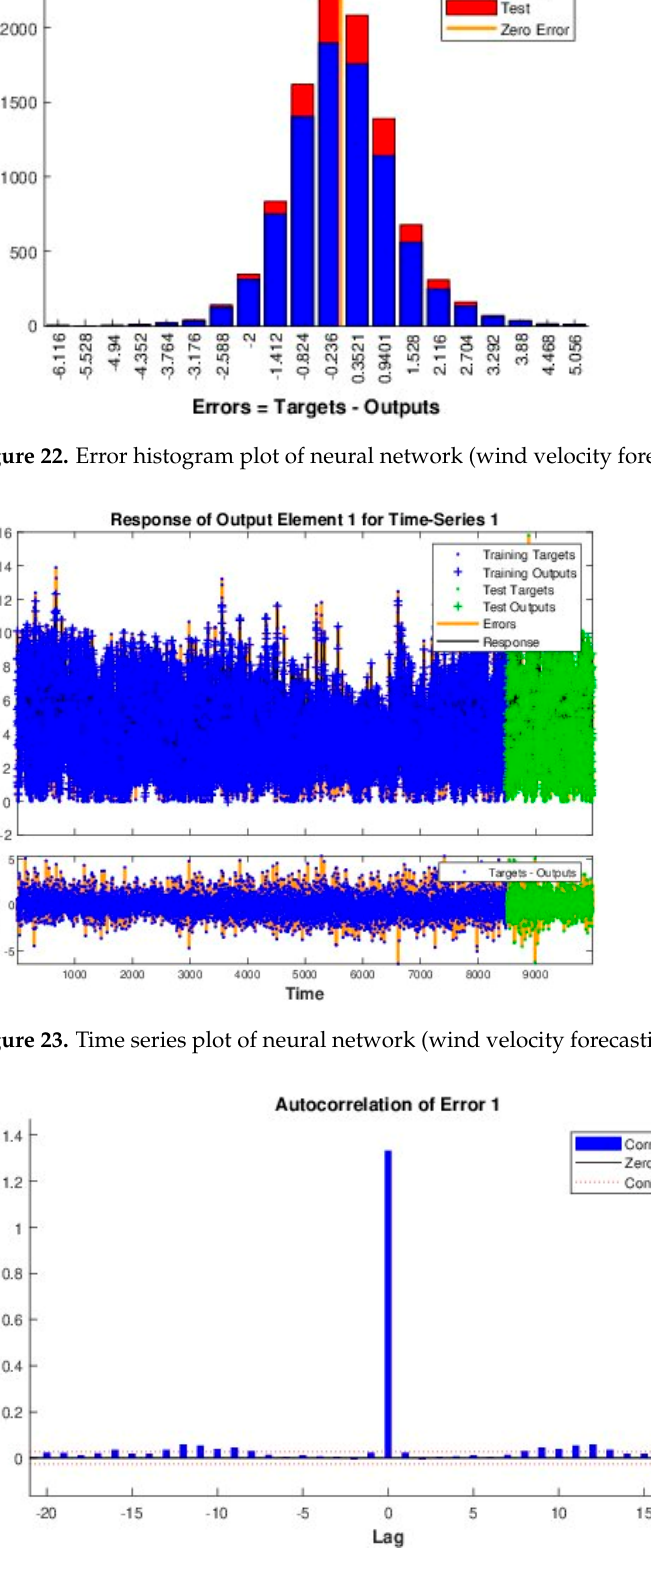
Figure 24. Autocorrelation plot of neural network (wind velocity forecasting case).